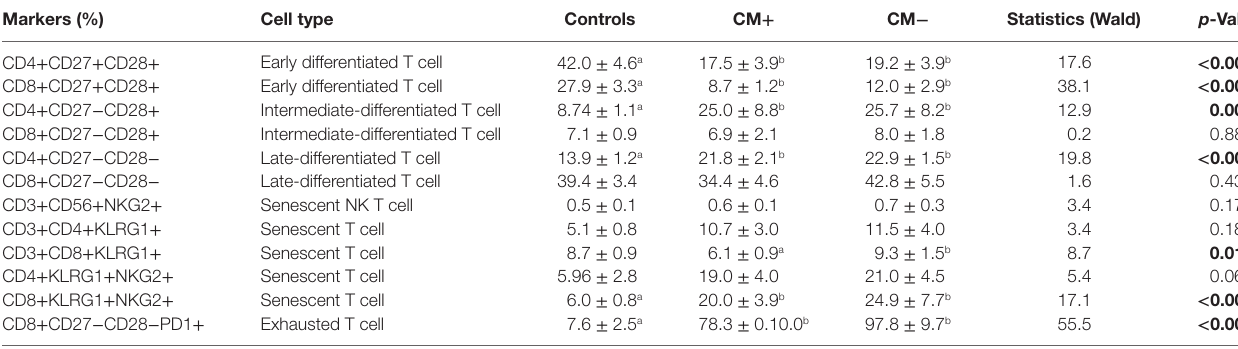
TaBle 3 | Different stages of T-cell differentiation and senescence-related markers. Markers